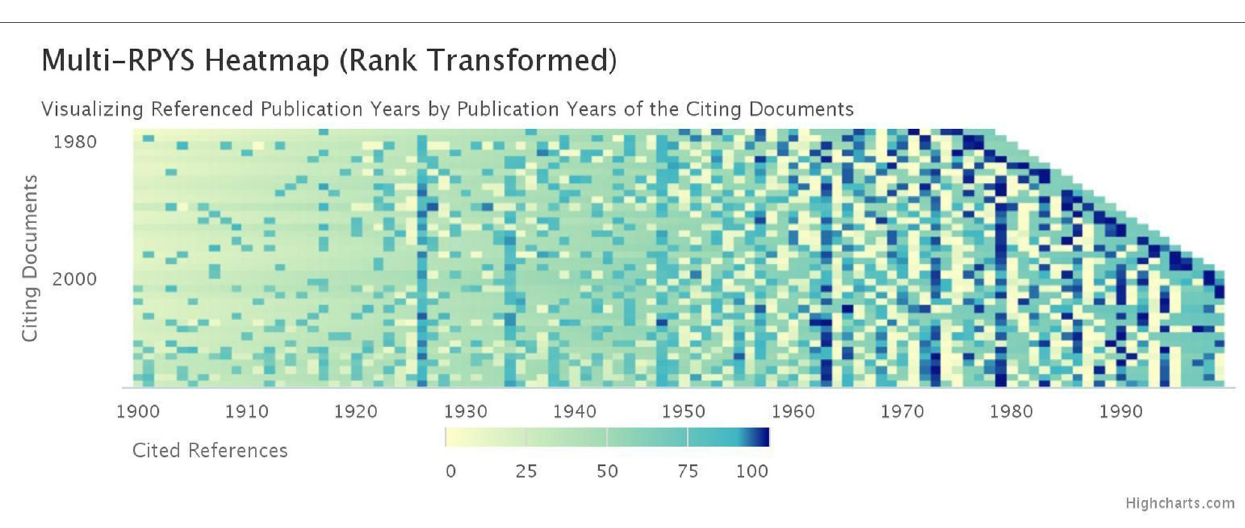
FigUre 10 | 3,777 articles published in Scientometrics , downloaded on January 2, 2016 . Source: http://comins.leydesdorff.net